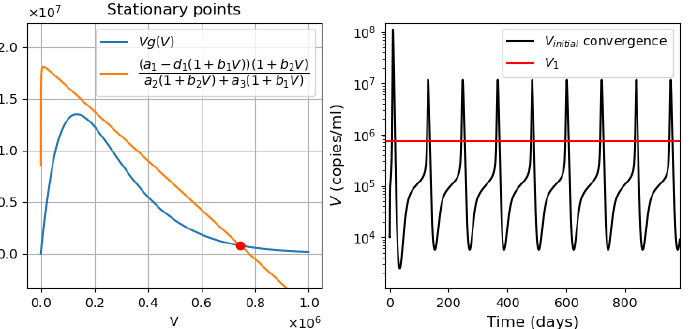
Figure 3. Left : graphical solution of Equation (9). Right : numerical simulations in the case of periodic oscillations with the initial viral load=10 4 , interferon secretion rate g 0 = 275, influx rate of uninfected epithelial cells k 1 =